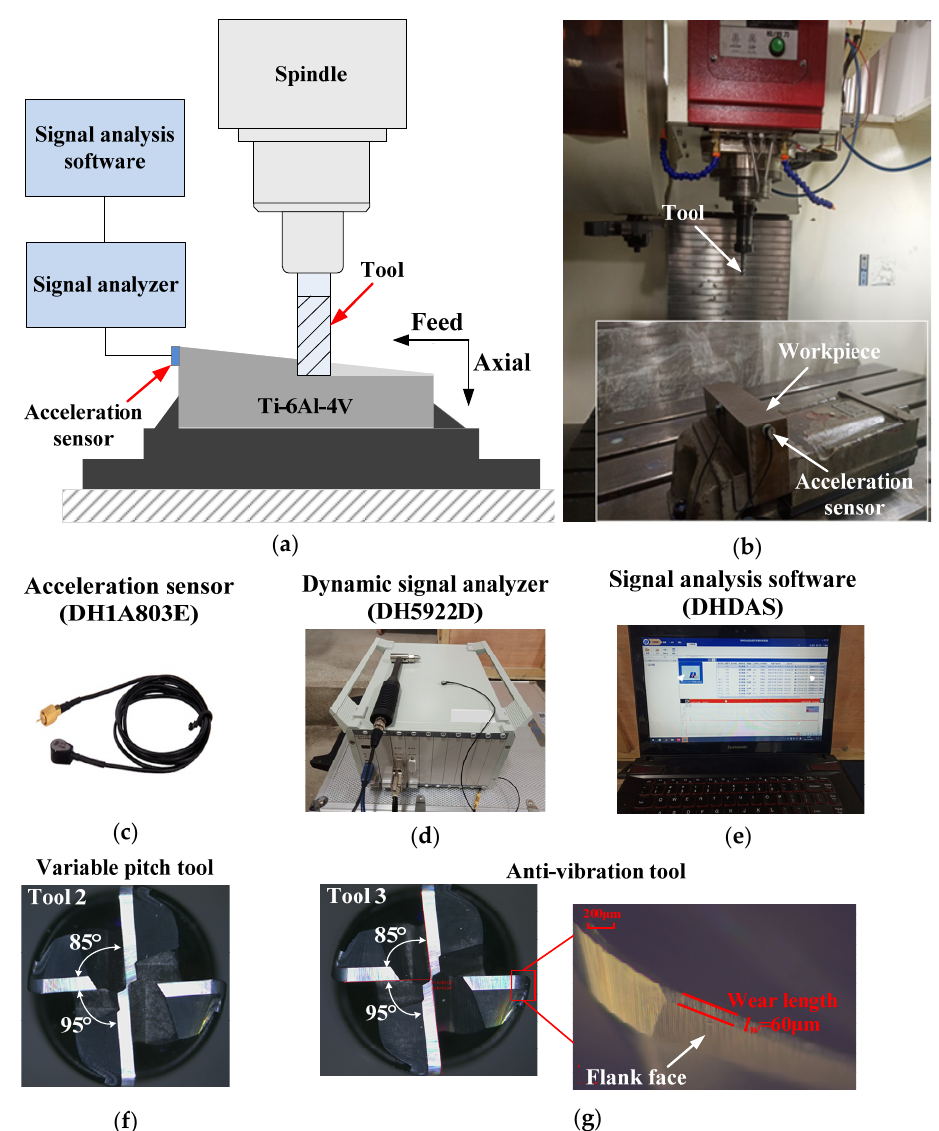
Figure 6. Experimental setup of milling tests; ( a , b ) are milling experiments scenes under industrial condition; ( c – e ) is acceleration signals acquisition equipment; ( f ) is the geometry and microstructure of and the variable pitch tool (tool 2); ( g ) is the geometry and microstructure of and the anti-vibration tool (tool 3).